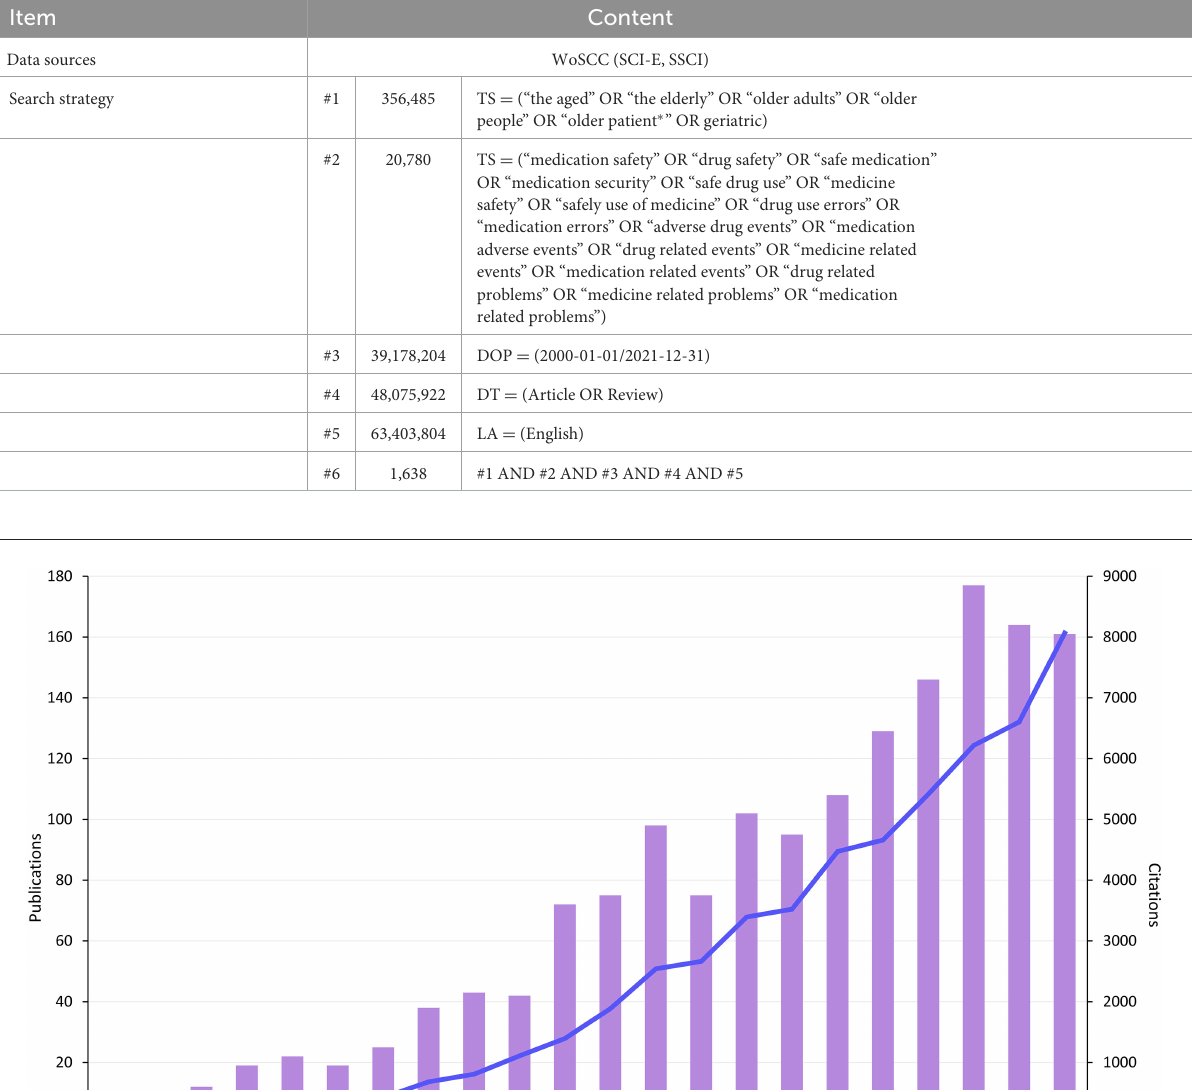
TABLE 1 Search strategy for the study of medication safety in older adults.